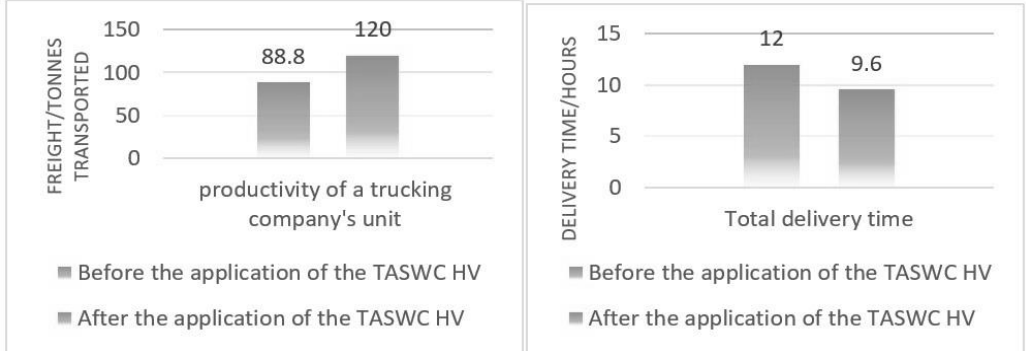
Figure 9. Evaluating the effectiveness of implementation TASWC HGV. Final calculations demonstrated that the total time of delivery of heavy cargo is reduced by 20%, and the productivity of the road transport company units is increased by